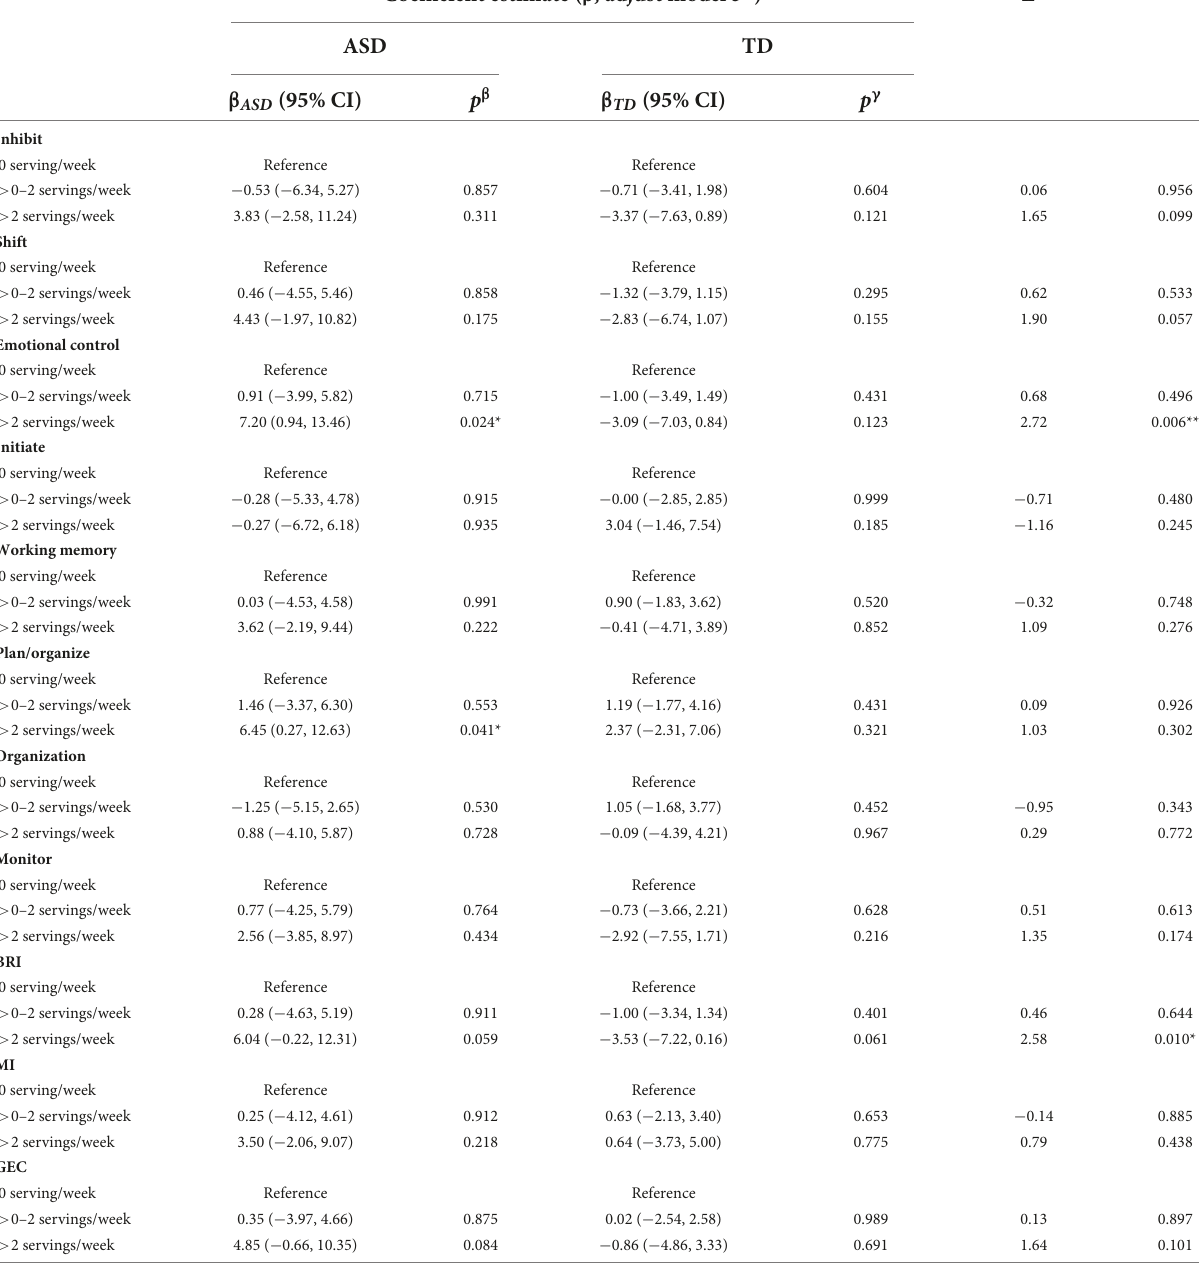
TABLE 2 Association between SSB consumption and scores of BRIEF among the two groups, and the comparison between the coefficient estimate ( β ) of the two groups. Coefficient estimate ( β , adjust model 3 α ) Z